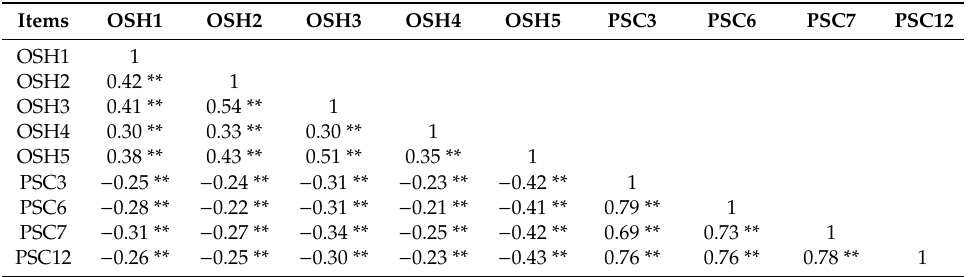
Table A2. Bivariate Spearman’s Rho correlations between the items covering OSH practices and PSC. Items